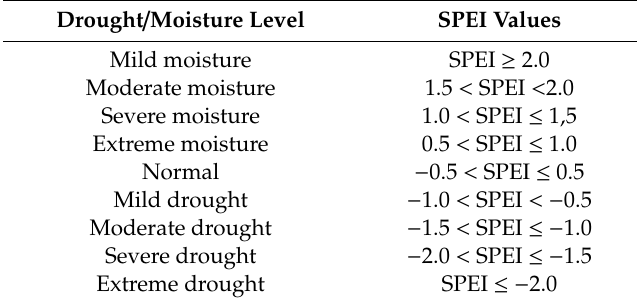
Figure 2. Methodological framework of this study. Table 1. Drought / moisture level based on